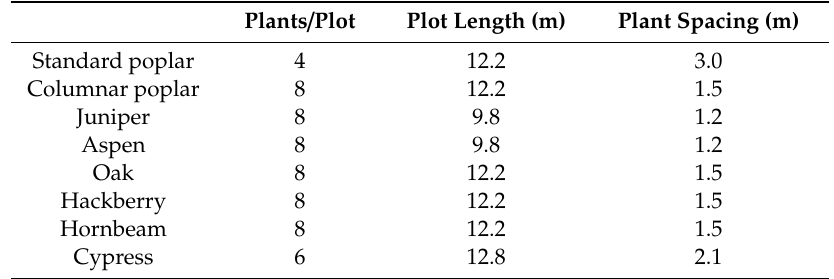
Table 1. Plot size (plant number and plot length) of windbreak species included in a trial at the Utah State University (USU) Kaysville Research Farm in Kaysville, UT, USA. Plant spacing was varied to accommodate the expected size of the species at maturity. Plant number was varied to reach a target plot length. Each species was included in three replicate plots arranged in a randomized block design. Plants / Plot Plot Length (m) Plant Spacing (m) Standard poplar 4 12.2 3.0 Columnar poplar 8 12.2 1.5 Juniper 8 9.8 1.2 Aspen 8 9.8 1.2 Oak 8 12.2 1.5 Hackberry 8 Hornbeam Cypress